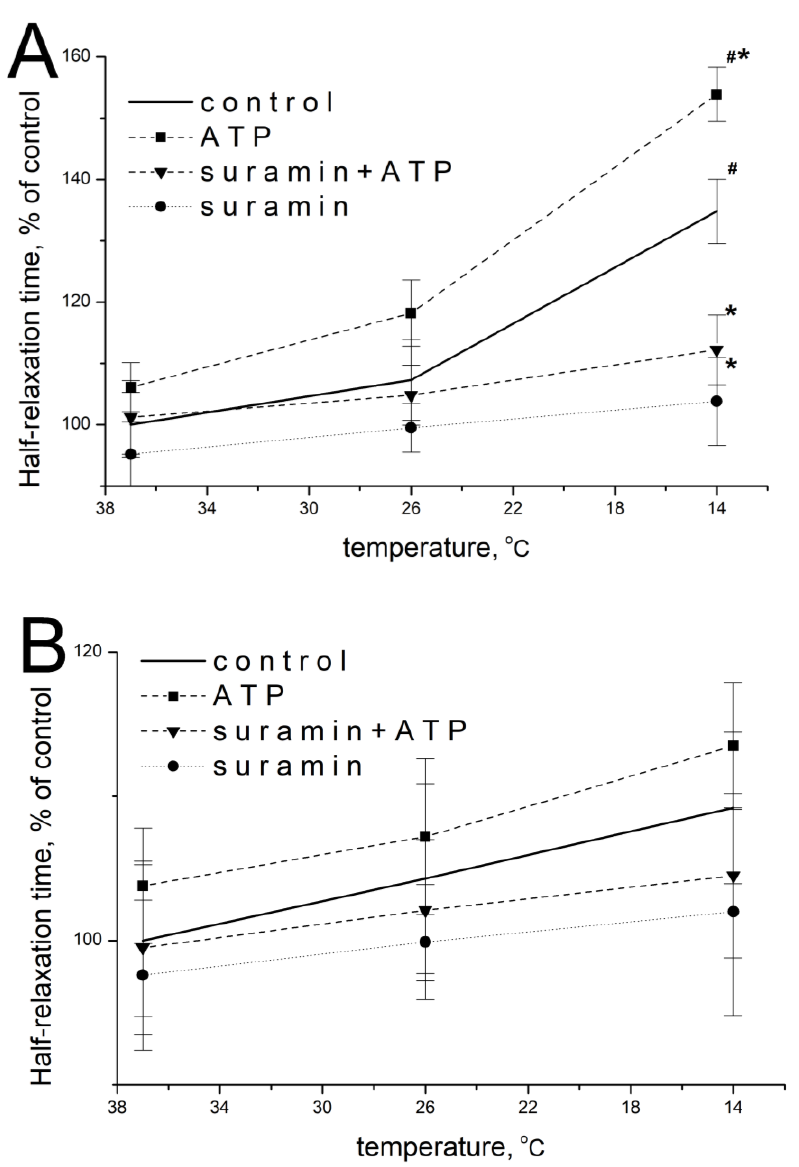
Figure 6. Effect of ATP on the half-relaxation time of m. soleus ( A ) and m. EDL ( B ) induced by carbachol under different temperature regimes. n = 9- 15. # p < 0.05 from the effect at 37 °C, * p < 0.05 from the control.